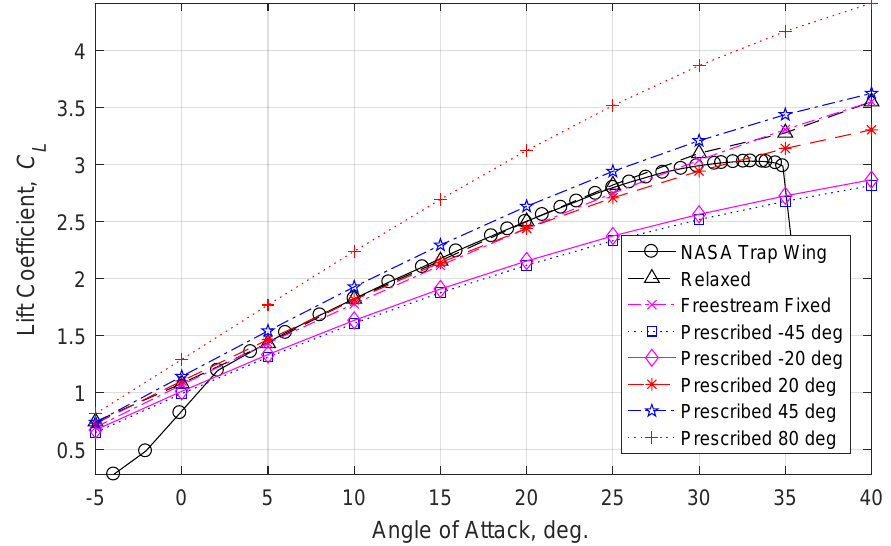
Figure 15. Comparisons of lift predictions using several wake types, and experimental observations, for the NASA Trap Wing LaRC Configuration